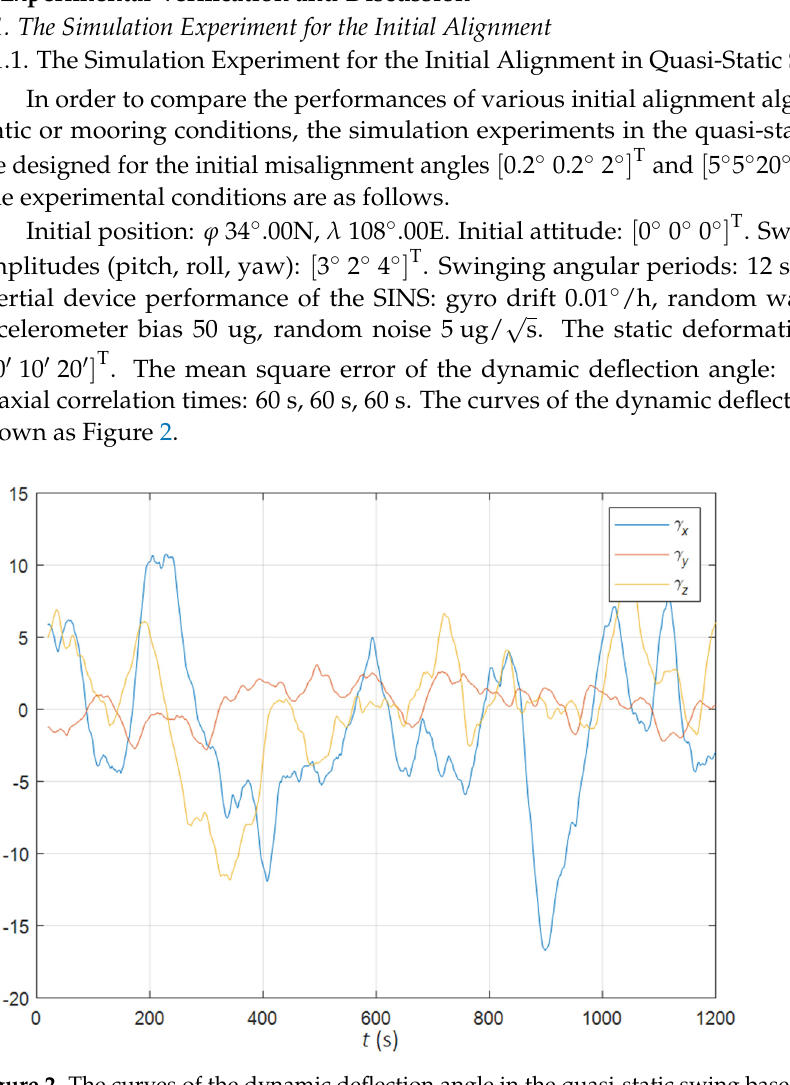
Figure 3. The error curves of E φ in the cases of the initial misalignment angles T [0.2 0.2 2 ] ° ° ° .